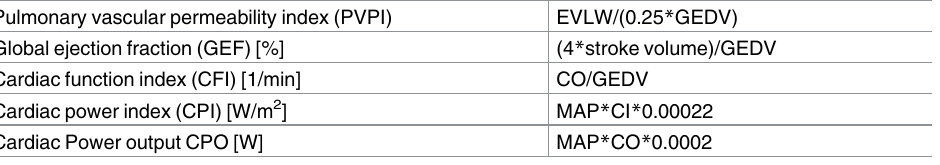
Table 1. Ratios and formulas derived from (transpulmonary) thermodilution and pulse contour